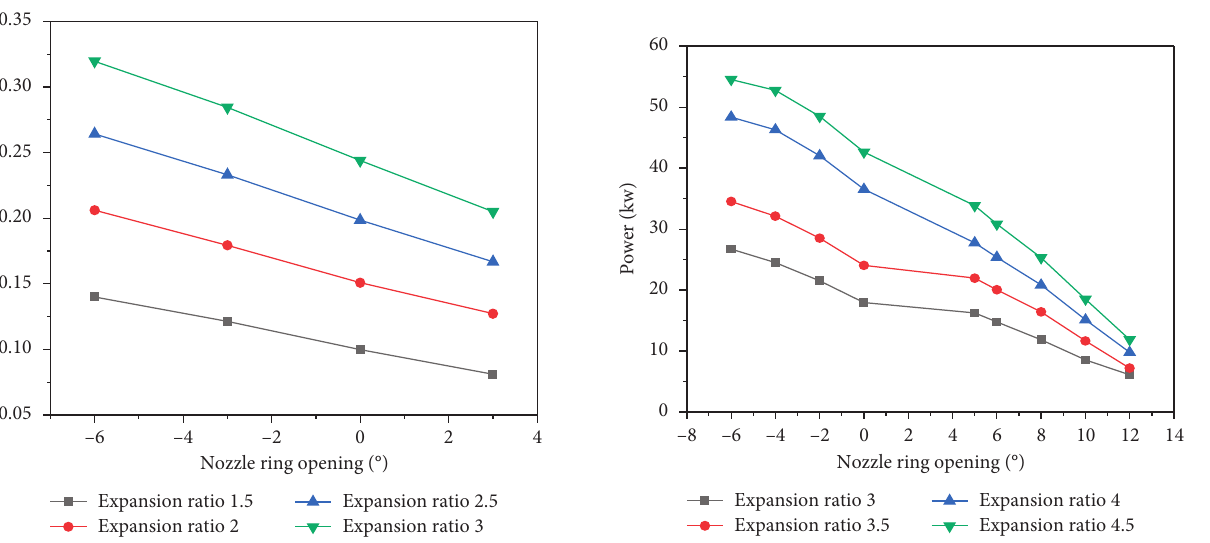
Figure 31: Relationship between opening and flow.